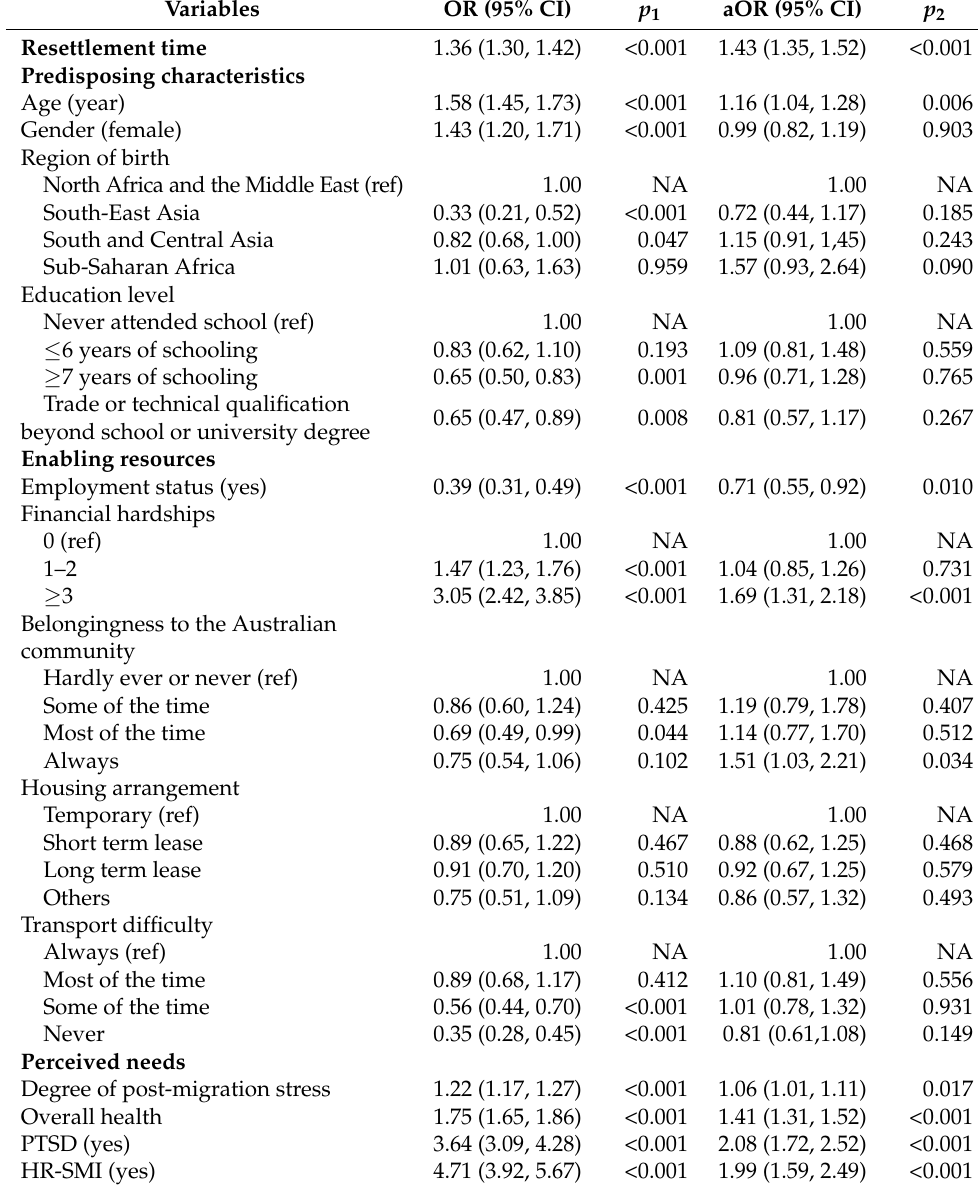
Table 2. Impact factors of having MHS contact among resettled humanitarian migrants over